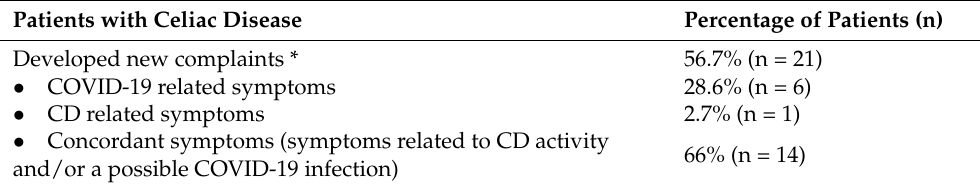
Table 2. Percentage of pediatric patients with celiac disease (CD) that reported an increase or a new occurrence of symptoms related to either CD activity, a possible COVID-19 infection, or both (concordant symptoms)* during the COVID-19 pandemic.